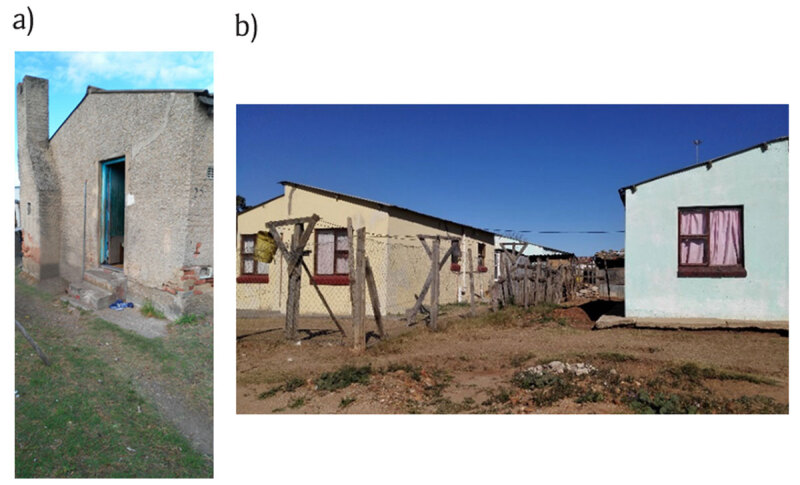
Examples of different dwelling types in (a) Walmer Township and (b) Wells Estate (Source: Captured by JT with permission from participants).